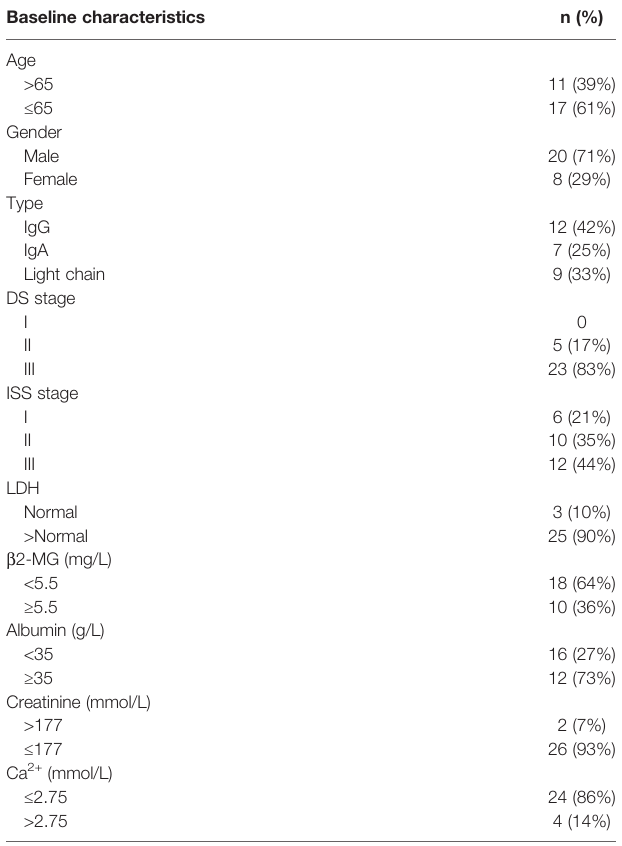
TABLE 1 | Clinical characteristics of 28 MM